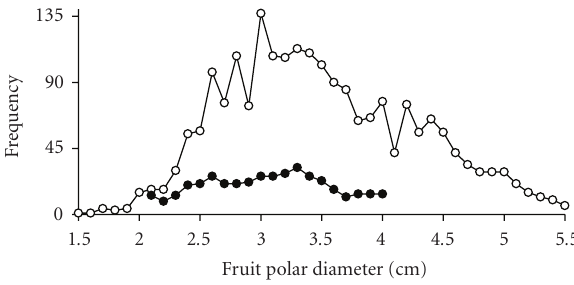
Figure 3: Distribution of damage ( • ) of C. dimidiatus with respect to polar diameter ( ) in guava fruits in Aguascalientes, Mexico. Oviposition frequencies ≥ 10 are